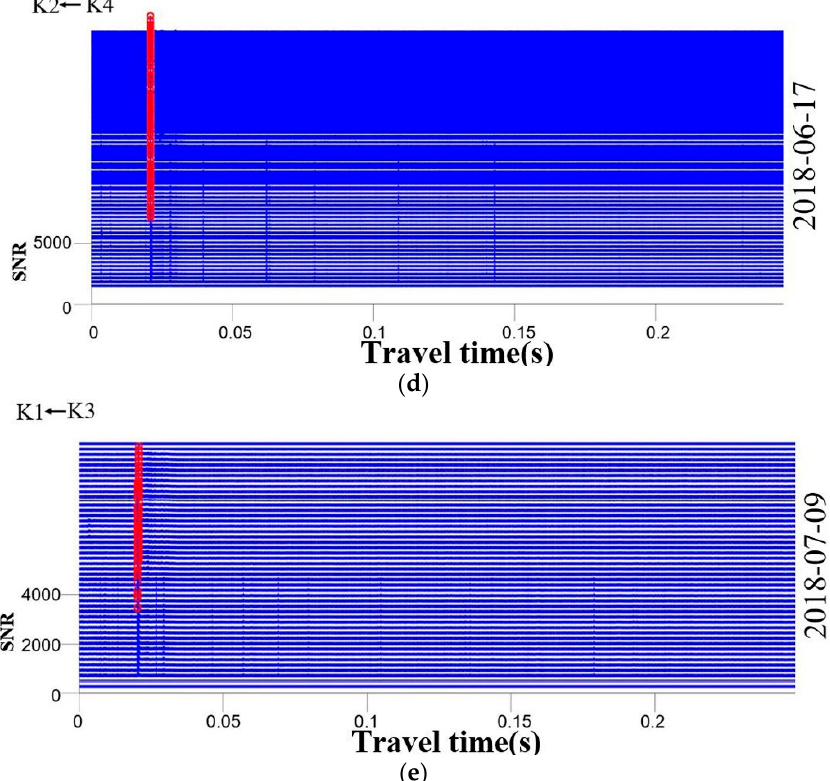
Figure 7. Correlation data. ( a ) Three-dimensional plot of travel time for the right triangle layout; ( b ) Travel time for the right triangle layout; ( c )Travel time for isosceles the triangle layout; ( d )Travel time for the rectangular layout; ( e )Travel time for the lozenge layout.